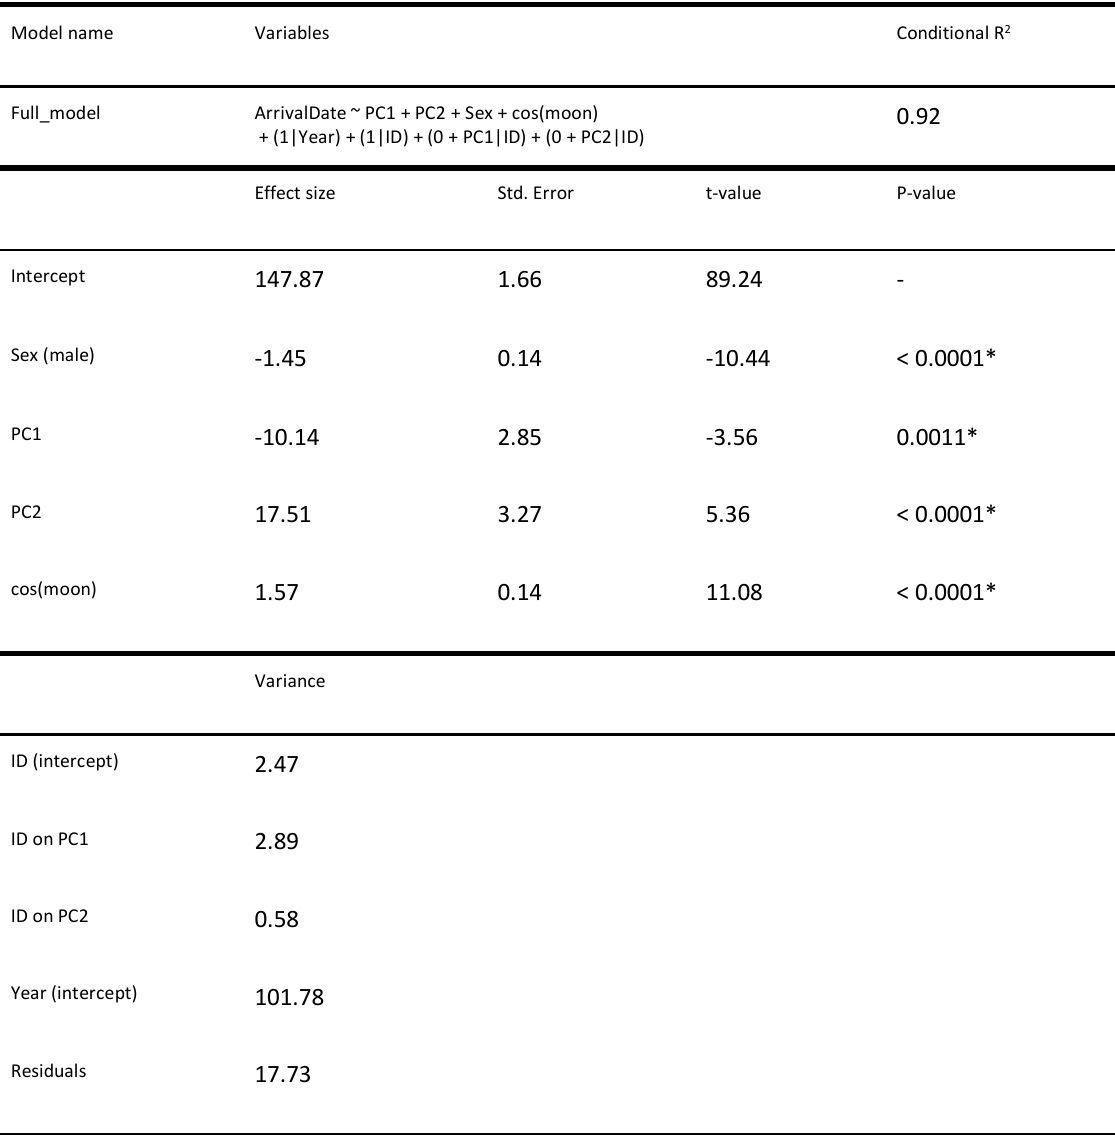
(Table 3). The 1000 models on the 1000 simulated datasets, ran to assess the robustness of the analysis to imperfect assignment of arrival dates, showed a similar outcome to the main model (Table S3). Table 3. Detailed description of the model used to check for the effect of environmental variables on the phenology at the individual level. Sex is included to observe differences between males and females. The response variable ArrivalDate is a vector of dates of arrival at the breeding site for each individual over the study period. PC1 and PC2 are the first two components of the PCA performed on the climatic data. Cos(moon) is the cosine of the lunar angle for the arrival date. ID refers to the identity of each individual, and it is used as a random effect on both intercept and the slopes of PC1 and PC2. Finally, Year is included as a random effect to account for additional unexplained variation that might be caused by sampling variation. The second and third part of the table provide details on the estimates for the fixed and random effects respectively. No p-values are provided for the intercept because this test is not of biological